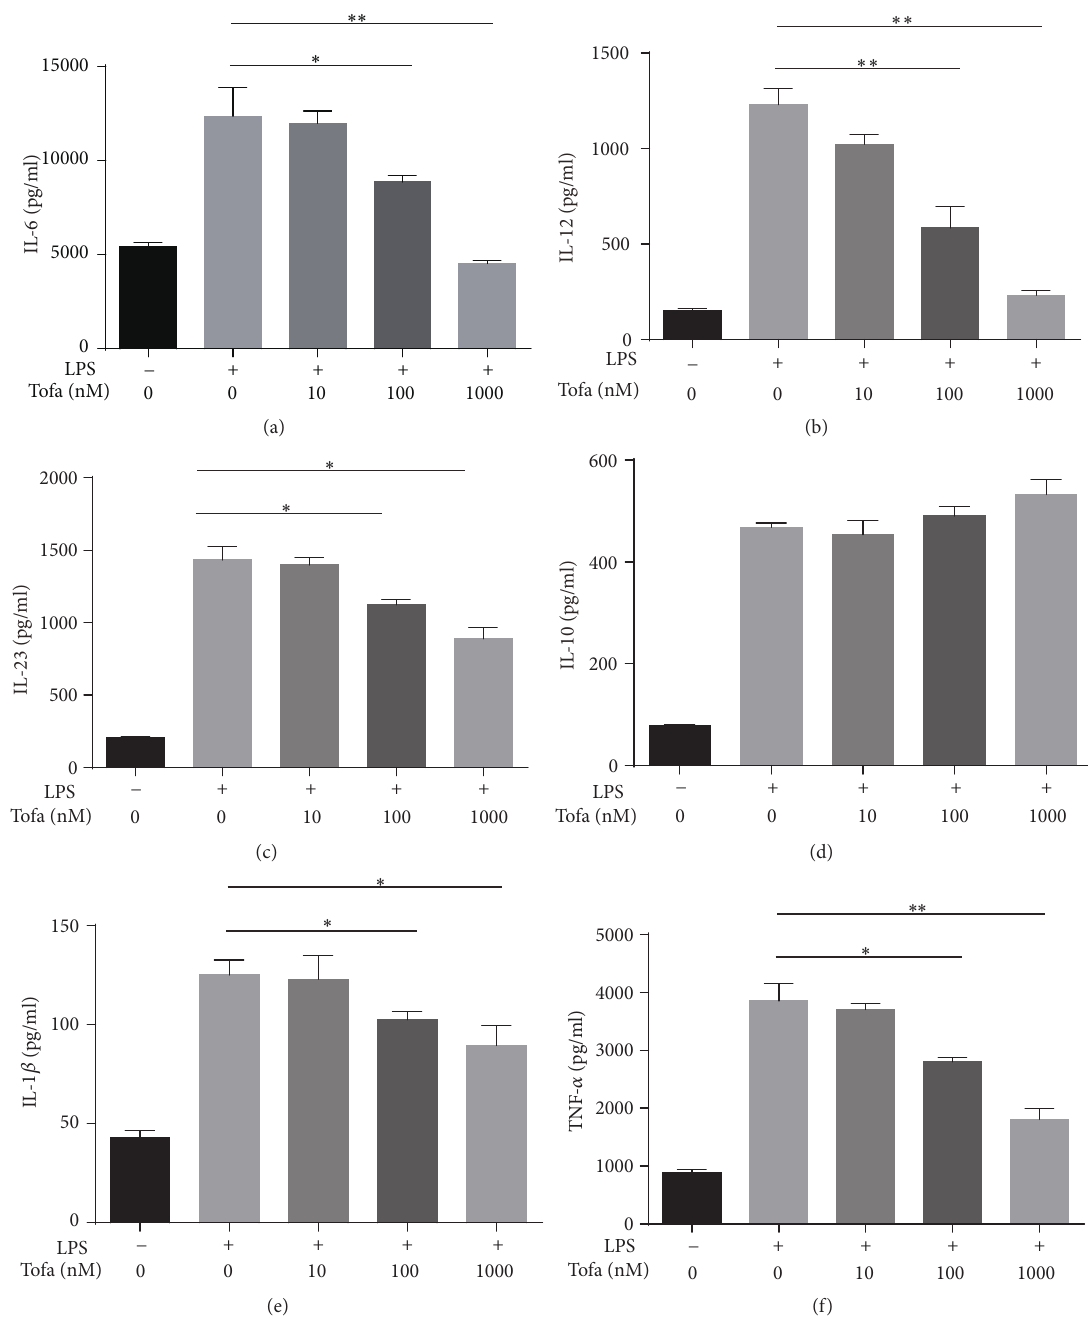
Figure 2: Tofacitinib inhibited secretion of proinflammatory cytokines. Levels of interleukin-6 (IL-6) (a), IL-12 (b), IL-23 (c), IL-10 (d), IL-1 𝛽 (e), and tumor necrosis factor- 𝛼 (TNF- 𝛼 ) (f) in supernatants containing each DCs subset were determined by enzyme-linked immunosorbent assay (ELISA). The representative results of three independent experiments with similar findings are shown. Statistical testing was performed using the Mann-Whitney test. Values represent the means ± SEM, ∗ 𝑃 < 0.05 , and ∗∗ 𝑃 < 0.01